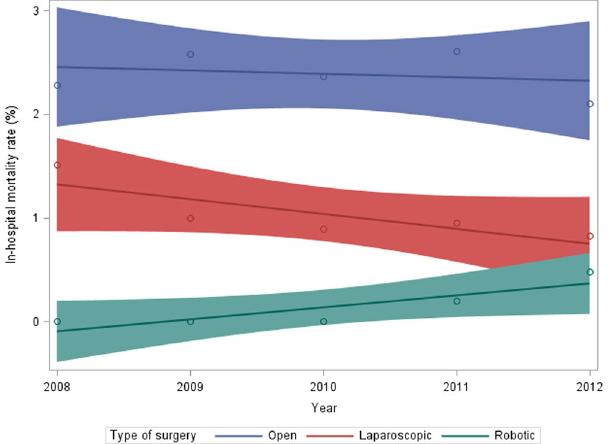
Figure 3. In-hospital mortality rate according to the type of surgeries, from 2008 to 2012. Circle represents the mortality rate in a given year, the straight line is a linear regression on all the data points, and the shaded area represents the 95% confidence limits for the linear